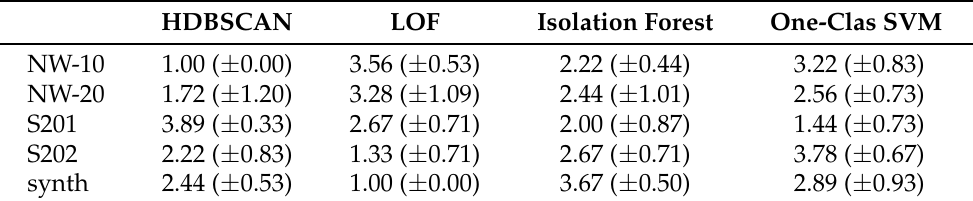
Table 3. Average ranking of the base models used in the proposed method—average of runs for different parameter values, without correction